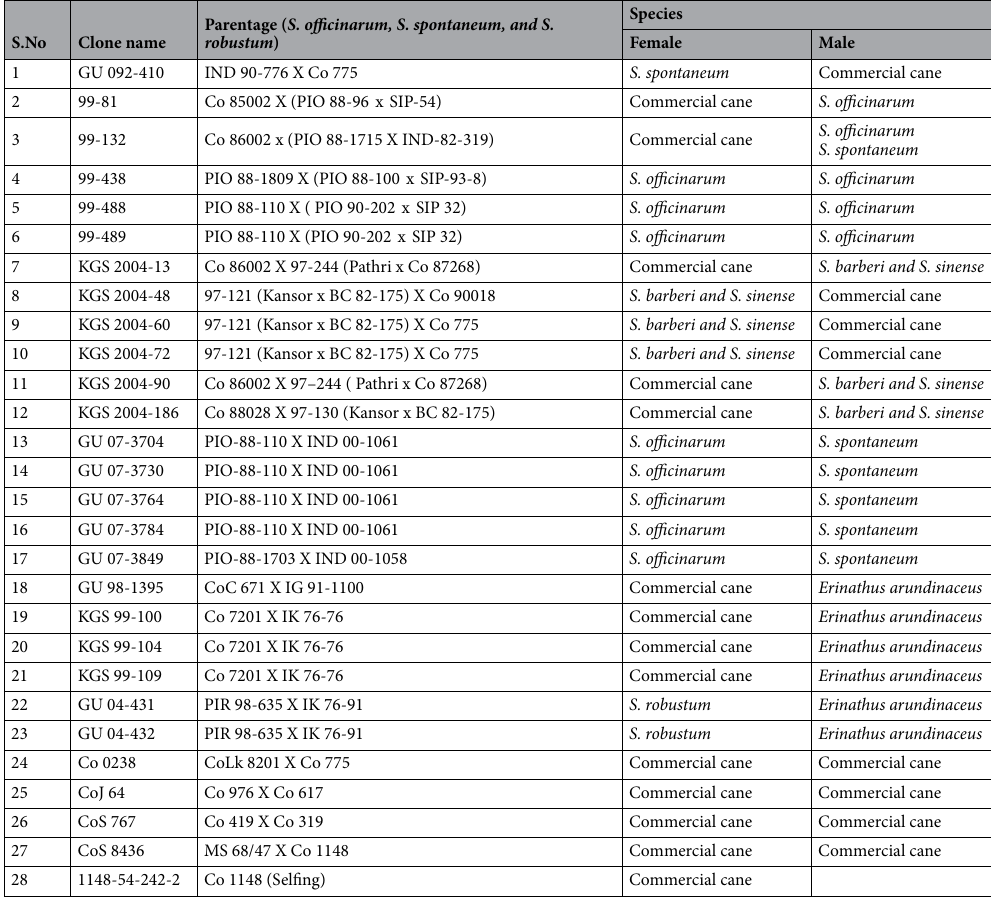
Table 1. Parentage of hybrid clones used in this study (S. no 1 to 17 are ISH clones, S.nos. 18 to 23 are IGH clones, 24 to 27 are commercial checks and, S. no. 28 is an inbred clone).